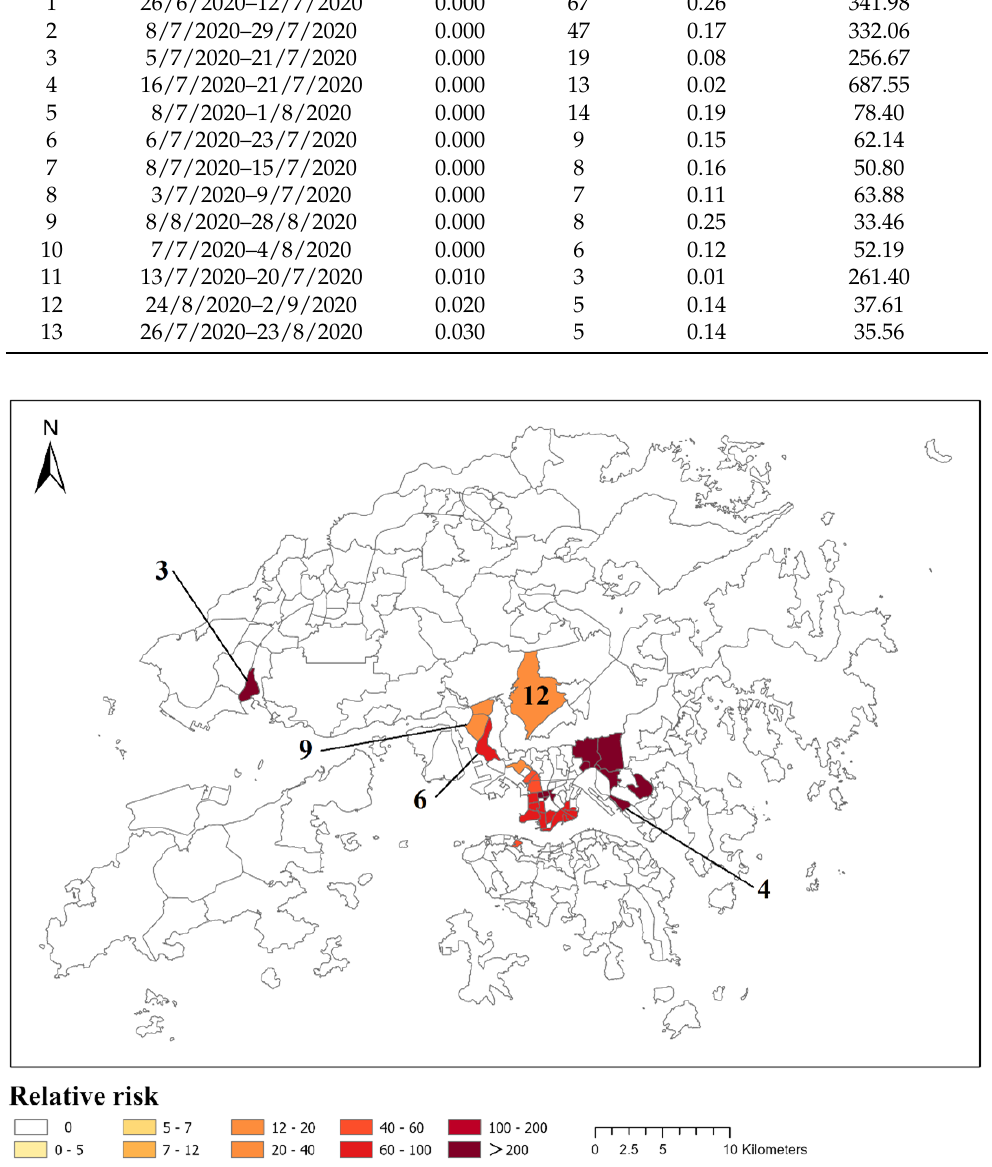
Figure 9. Space–time cluster distribution in stage II at non-residential locations (In which number 3, 4, 6, 9, 12 indicate the most significant